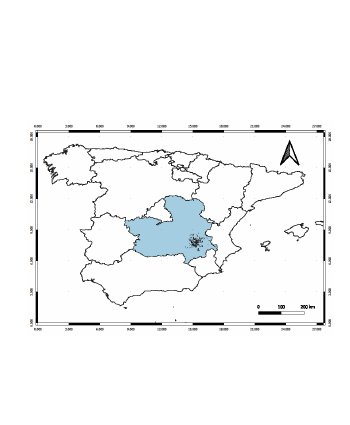
Figure 1. Locations of the reference data.